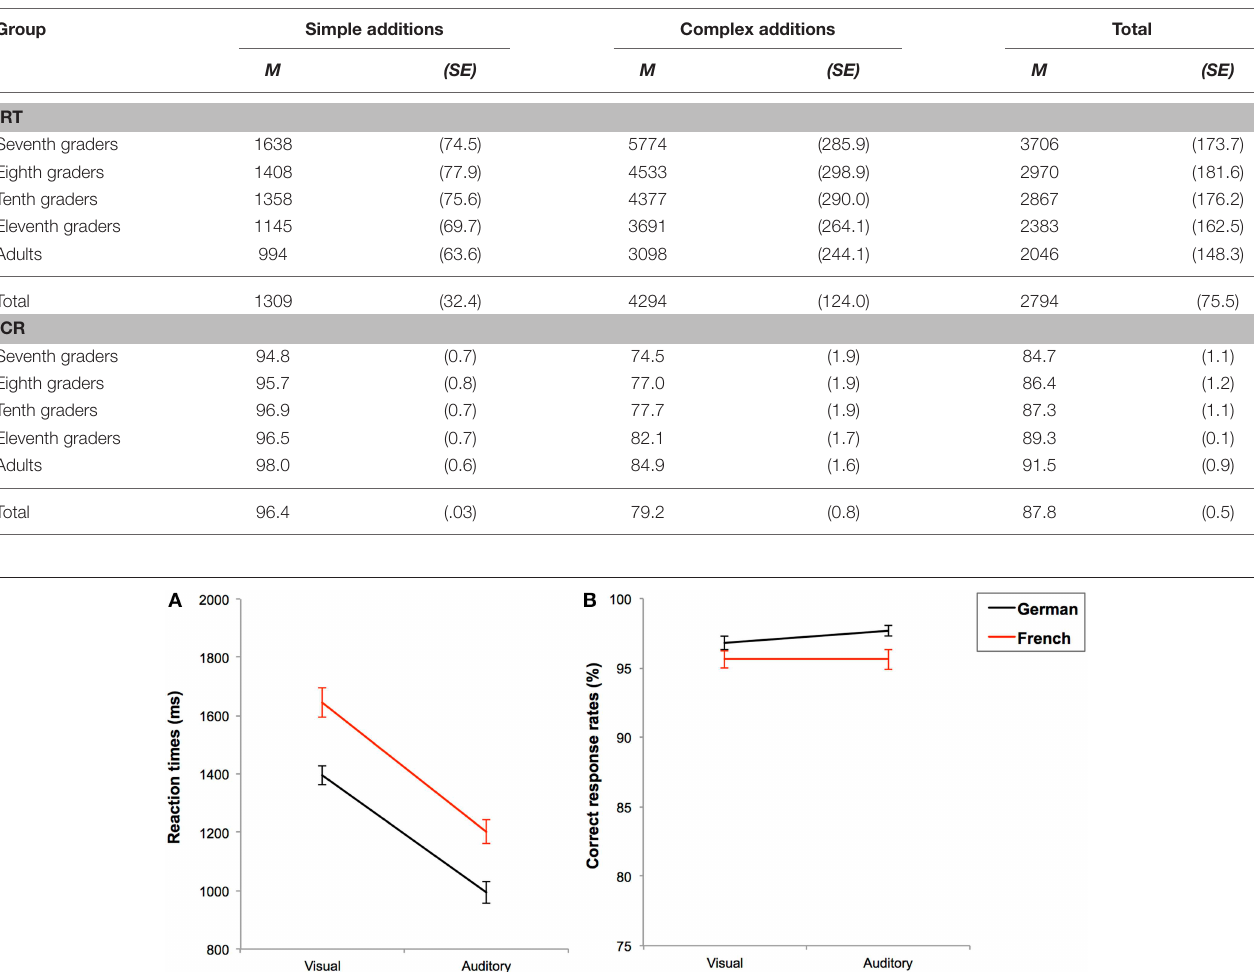
TABLE 2 | Means of reaction times (RT) in ms and correct response rates (CR) in % with standard errors for each complexity level of the additions (simple vs. complex) and the general mean performances as a function of age-group.